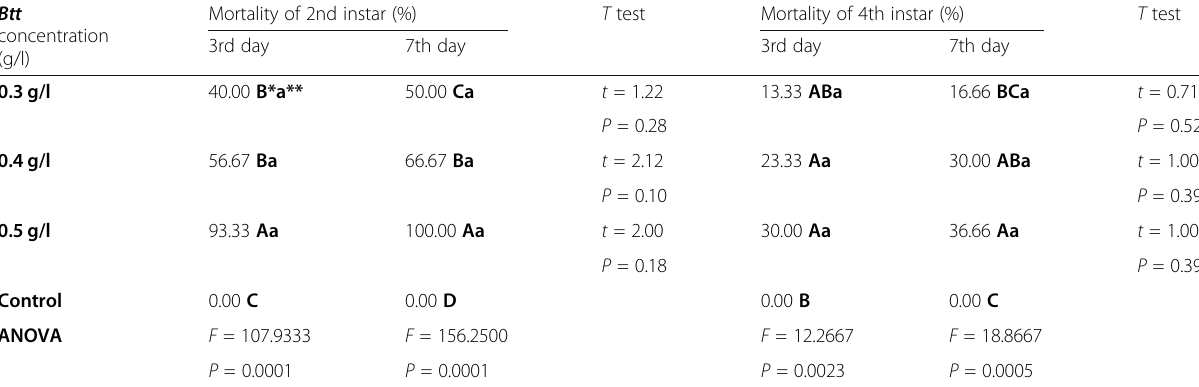
Table 1 Effects of Bacillus thuringiensis var. thuringiensis against Syllepte derogata larvae under laboratory